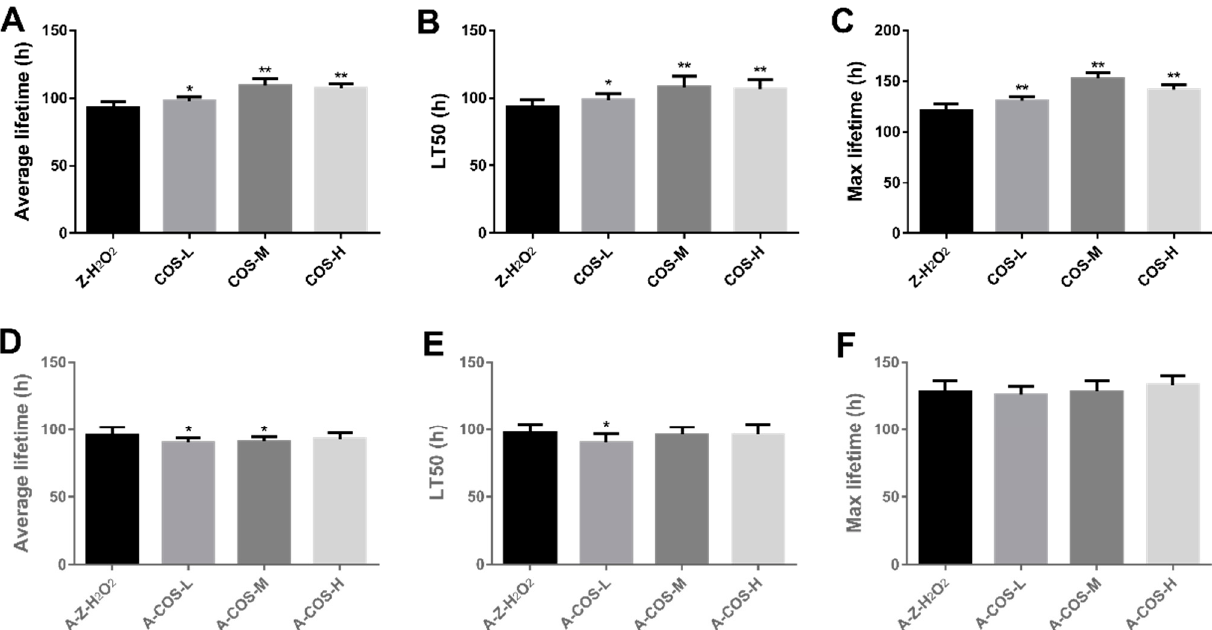
Figure 1. The survival curve of H 2 O 2 ‐ induced female Drosophila with different feeding: ( A ) normal fruit flies, ( B ) axenic fruit flies.